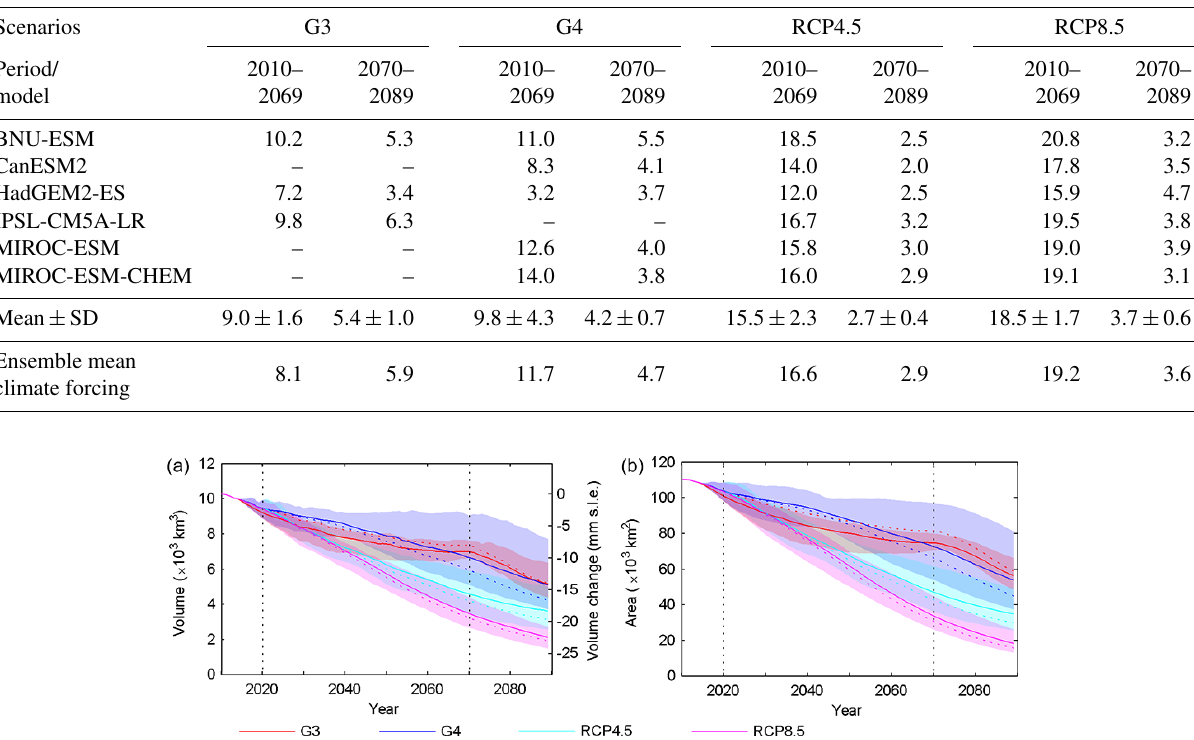
Table 5. The volume loss in millimetre sea-level equivalent, projected using forcing from all the climate models in the period 2010–2069 and the post-geoengineering period 2070–2089 under G3, G4, RCP4.5, and RCP8.5. The means of volumes lost driven by individual model forcing and its standard deviation are shown in the penultimate row. The simulated volume loss using the climate model ensemble mean forcing of temperature and precipitation is shown in the last row. The volume loss is calculated by assuming ice density of 900kgm − 3 and ocean area of 362 × 10 12 m 2 .